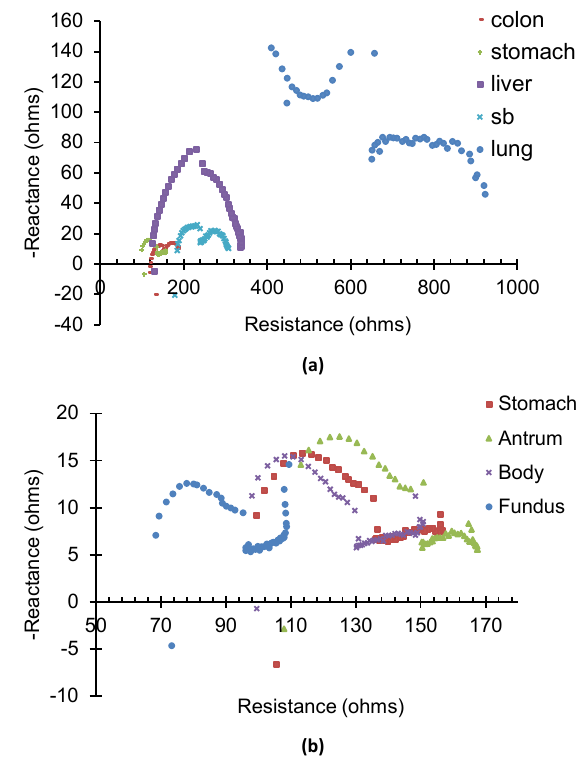
Fig. 5. Nyquist plots for EIS measurements. (a) Comparison between all measured tissue types: colon, liver, small bowel, lung, and aggregate stomach. (b) Comparison between just stomach segments (fundus, body, antrum) and all stomach data taken as an